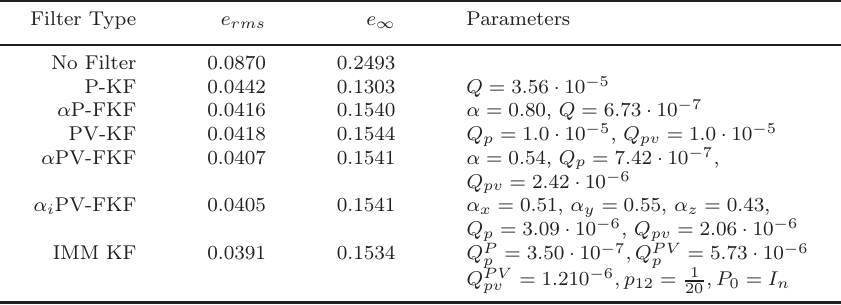
Table 2. Performance of different Kalman Filters for the HAND data